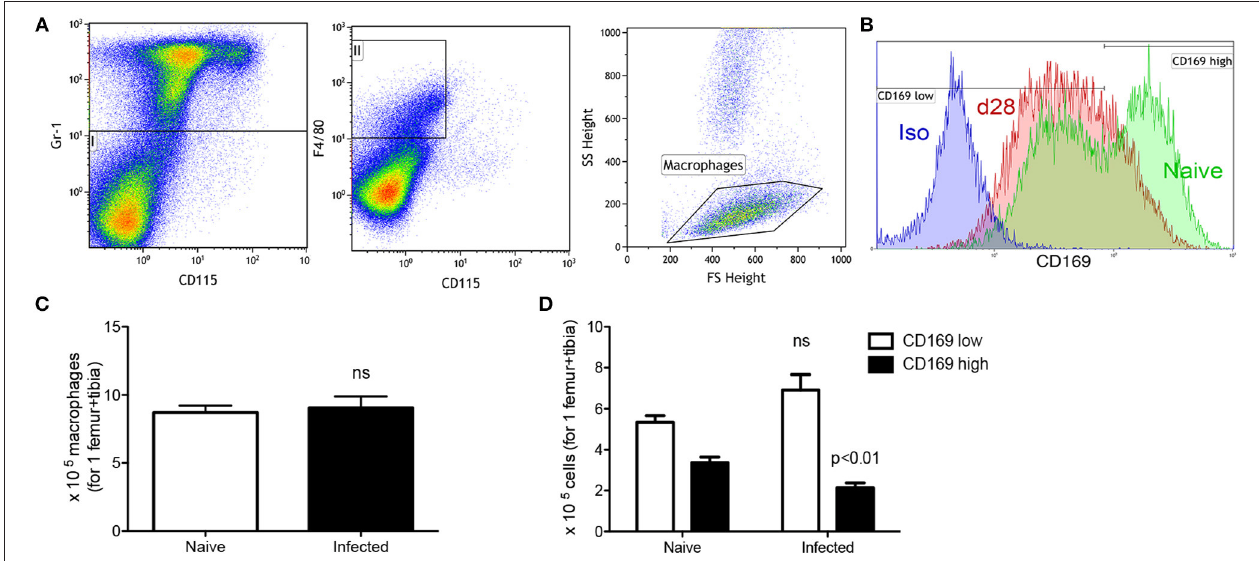
FIGURE 3 | Infection with L. donovani reduces the number of CD169 + stromal macrophages in BM. (A) BM stromal macrophages were identified as Gr-1 − CD115 − F4/80 + SSC low cells (9). (B) CD169 expression on BM macrophages of naïve (green) and infected (red) mice. Isotype control (blue) is representative of both naïve and infected mice. (C) Absolute number of macrophages per leg (1 femur + 1 tibia) according to the gating described in (A,B) . (D) Absolute number of CD169 low and CD169 high stromal macrophages based on gating in (B) . Absolute numbers were calculated from the frequencies multiplied by the total bone marrow cells isolated from each mouse. Data represent mean ± SEM. All experiments were performed 28 days after infection (unpaired t -test; n = 10 mice per group from two independent experiments).